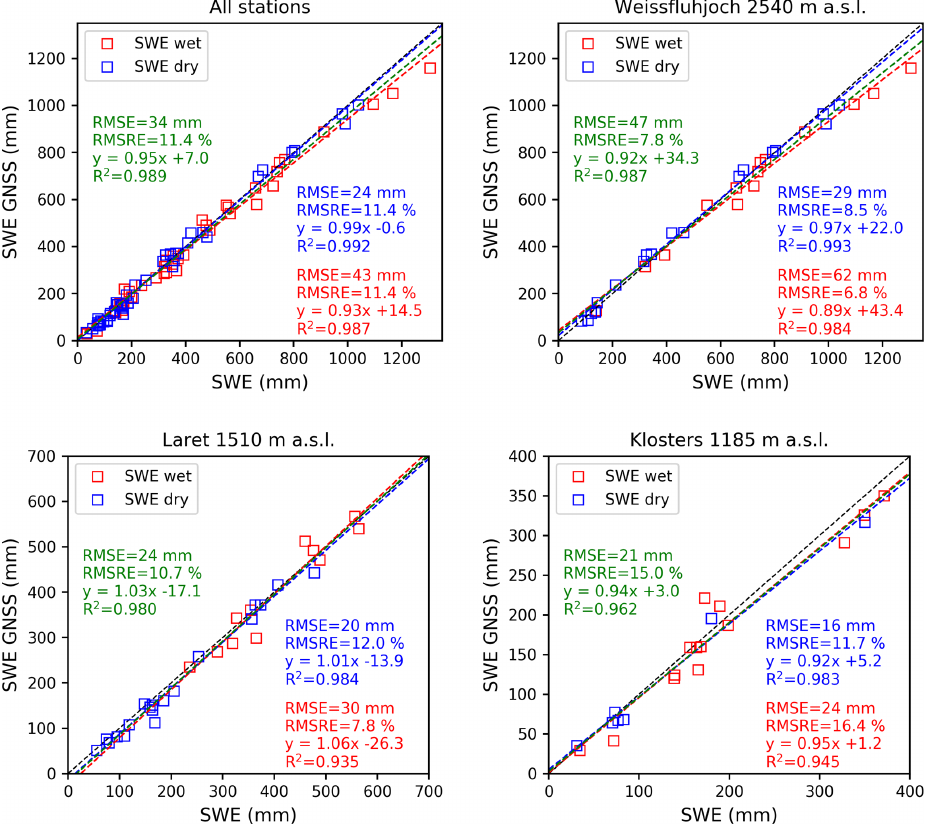
Figure 4. Scatter plots of GNSS-derived SWE vs. manually measured SWE for dry-snow conditions (blue) and wet-snow conditions (red) for all sites together and the single sites (for both winter seasons). We do not show the data for Küblis because only a few data points were available. The dashed lines represent the linear regressions (green for dry- and wet-snow data jointly). Data points with SWE < 25mm were excluded from the analysis. The 1:1 line is shown in